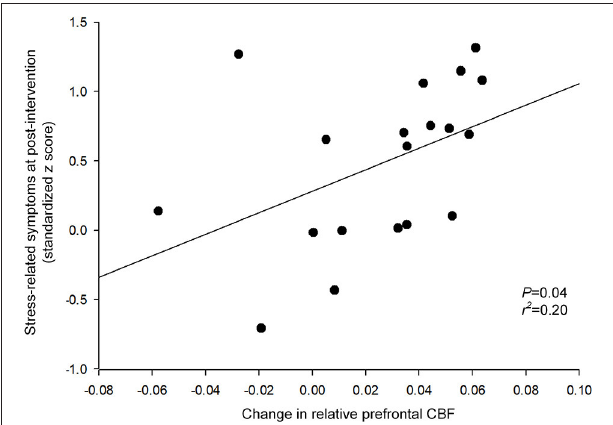
FIGURE 3 | Relationship between changes in relative prefrontal CBF and stress-related symptoms at post-intervention. A greater magnitude of relative CBF increase in the prefrontal region was associated with better stress-related composite scores following the intervention ( t = 2.22, P = 0.04). The relationship was tested using a robust regression model that included the following variables: changes in relative prefrontal CBF as an independent variable, and the stress-related symptoms at post-intervention as a dependent variable. The regression line is indicated in a solid line. CBF, cerebral blood flow.